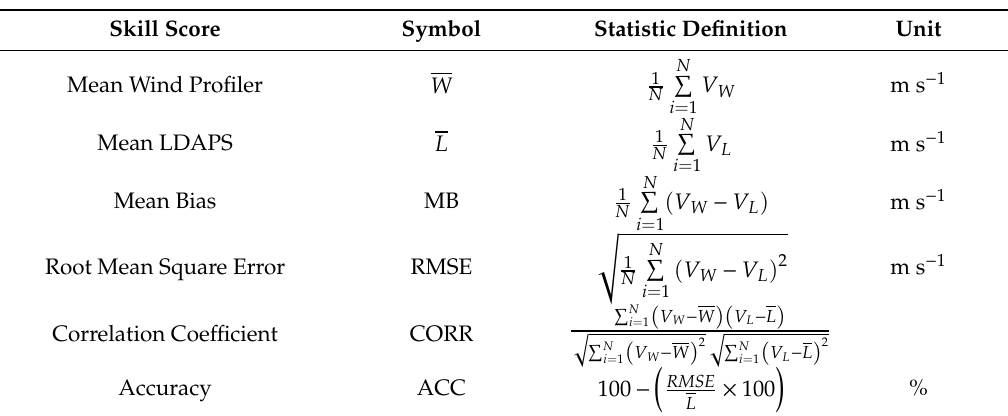
Table 3. Skill scores for accuracy validation of wind